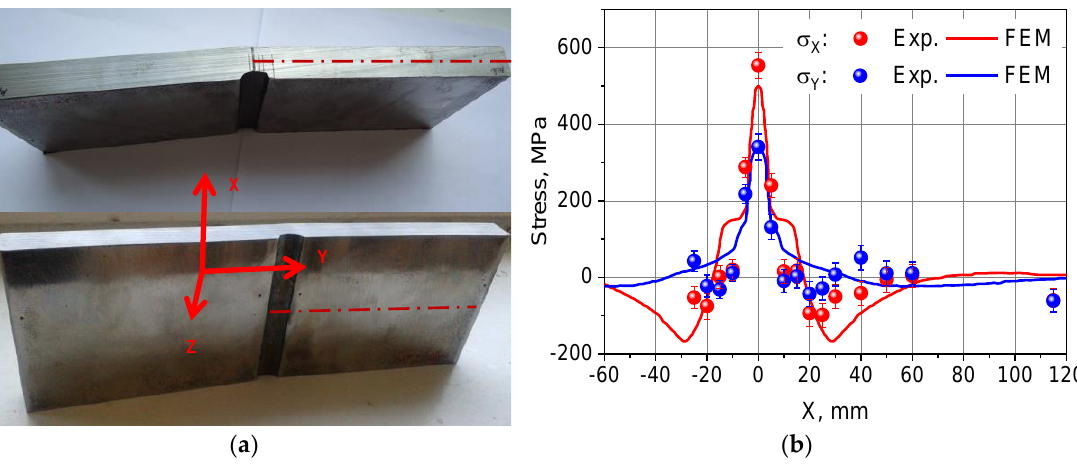
Figure 14. ( a ) Multi-pass butt-welded (GMAW+SAW) specimen (300 × 100 × 20 mm 3 ). ( b ) Longitudinal σ X and transverse σ Y stress distribution in a multi-pass butt-welded joint measured by neutron diffraction and calculated by FEM, adapted from [34], with permission from © 2017 Elsevier.